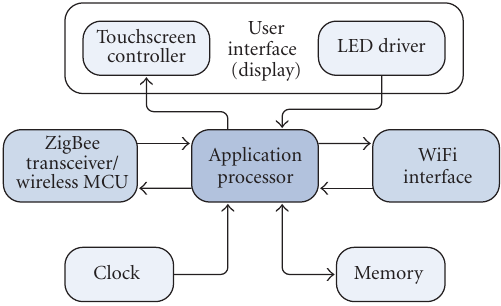
Figure 10: Architecture of the Home Energy Angel smart